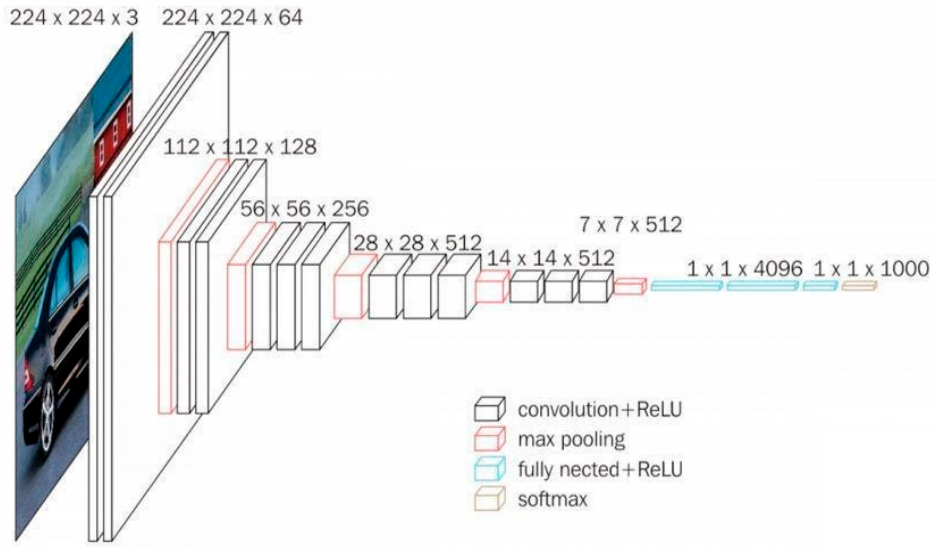
Figure 4. The original VGG16 architecture.